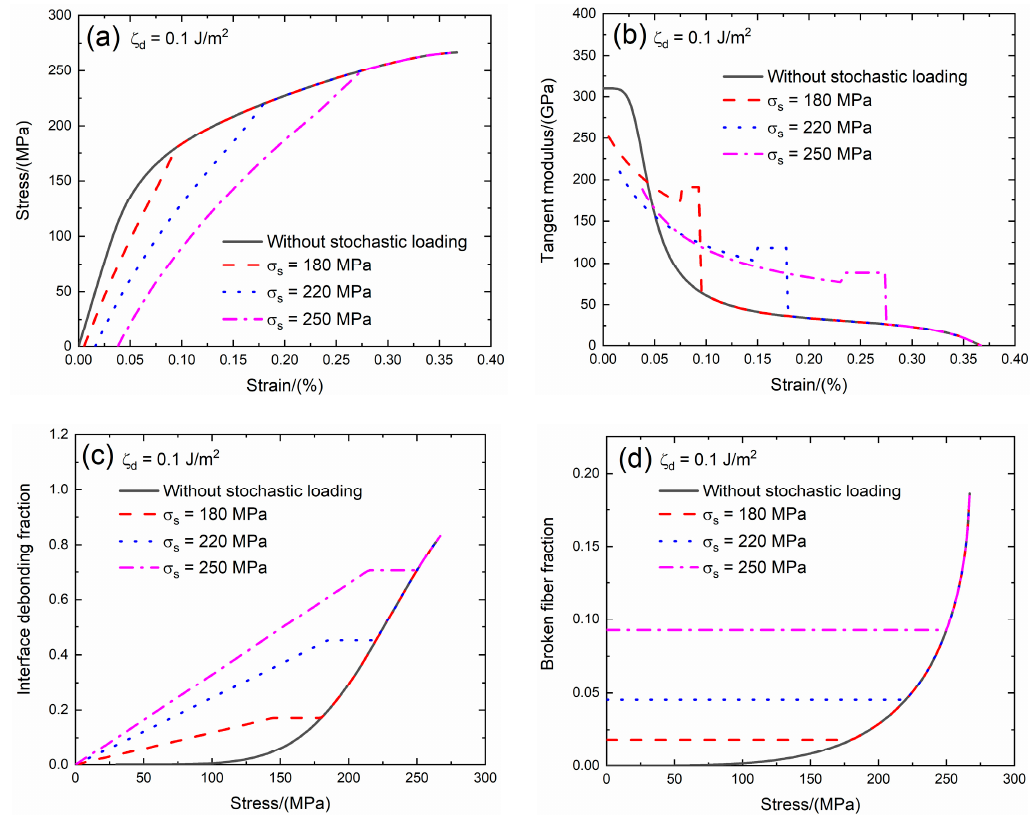
Figure 7. ( a ) The tensile stress–strain curves; ( b ) the tangent modulus versus strain curves; ( c ) the interface debonding fraction versus stress curves; and ( d ) the broken fibers fraction versus stress curves of SiC/SiC composite for conditions without stochastic loading and with stochastic loading of σ s = 180, 220 and 250 MPa when ζ d = 0.1 J/m 2 .